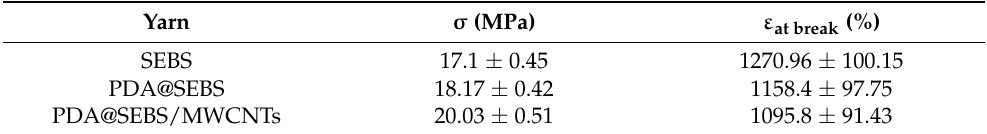
Tensile strength ( σ ) and elongation at break ( ε at break ) for PDA@SEBS and PDA@SEBS/MWCNTs